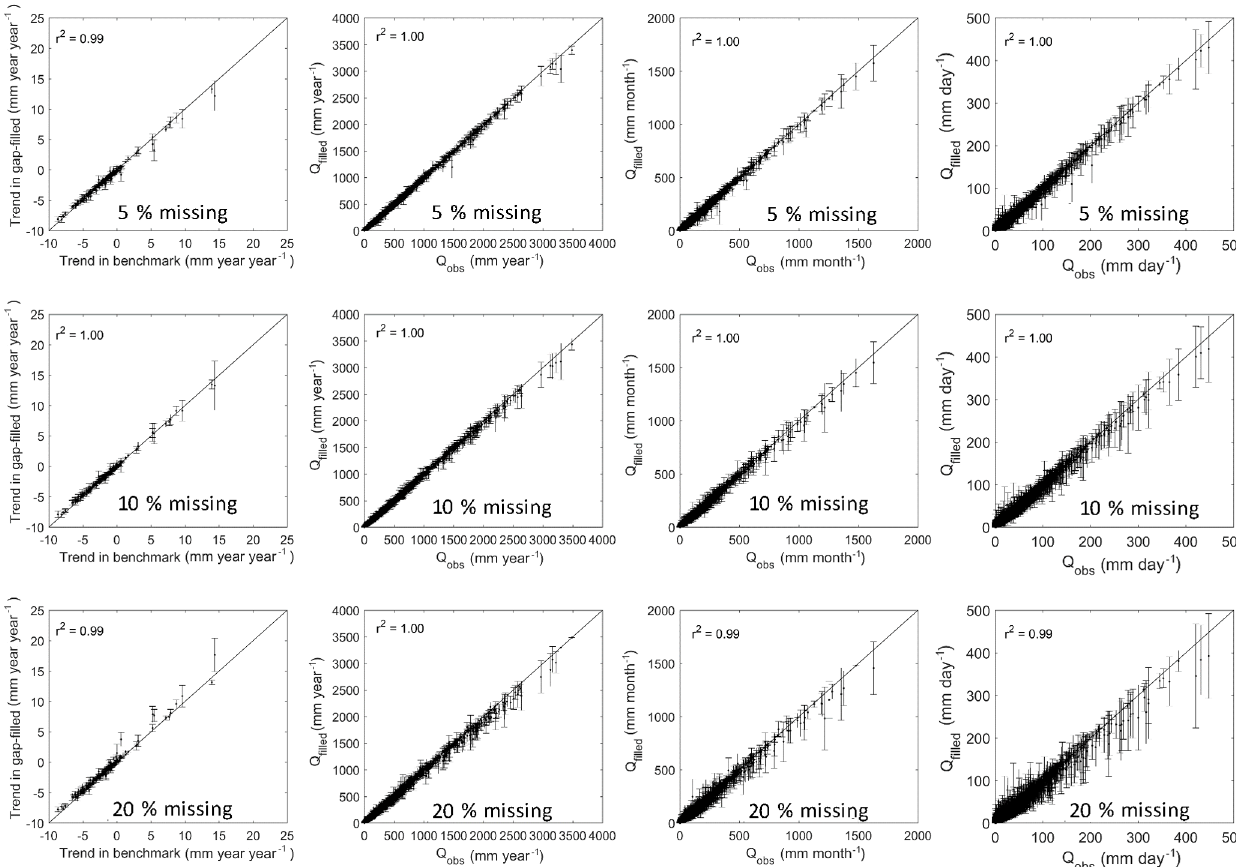
Figure 7. Same as Fig. 6 but using